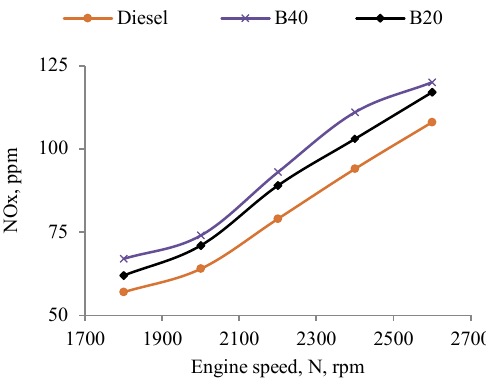
Fig. 13. NO X emission in diesel engine for diesel and biodiesel